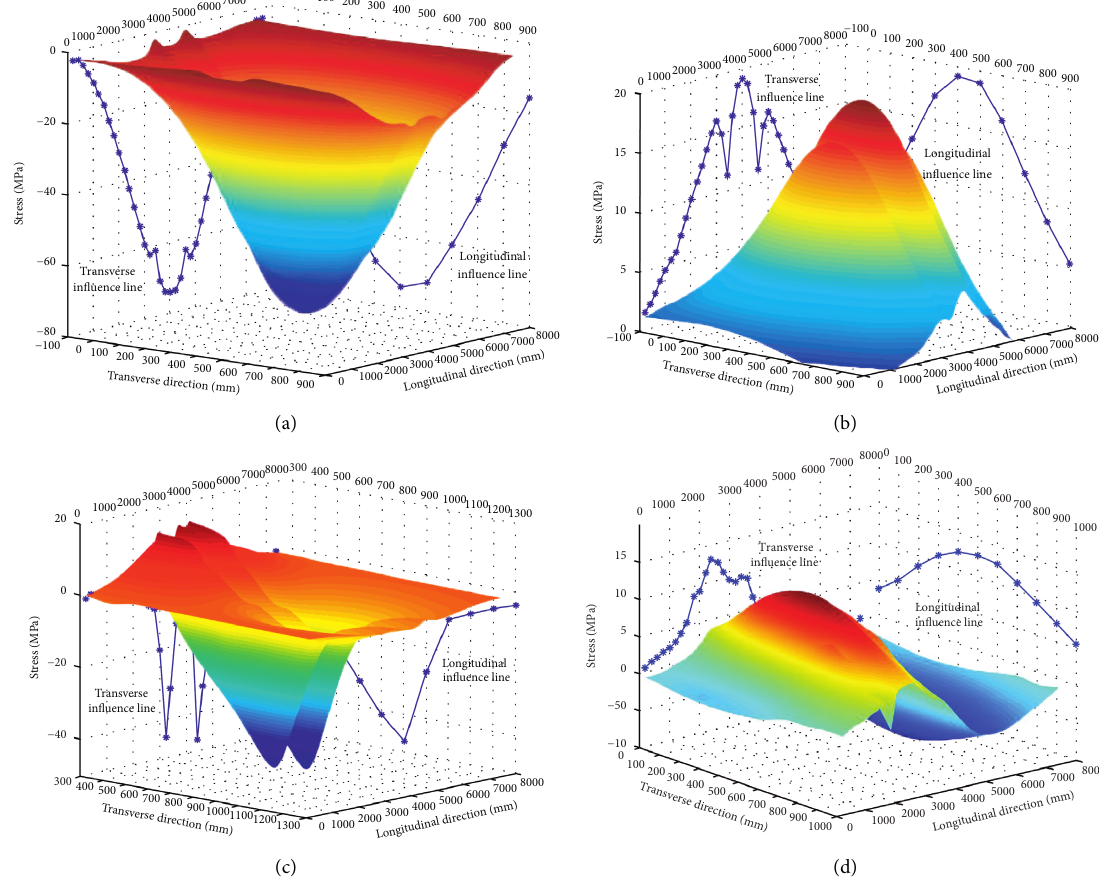
Figure 11: Fatigue detail influence surface. (a) DC. (b) RDI. (c) DL. (d)